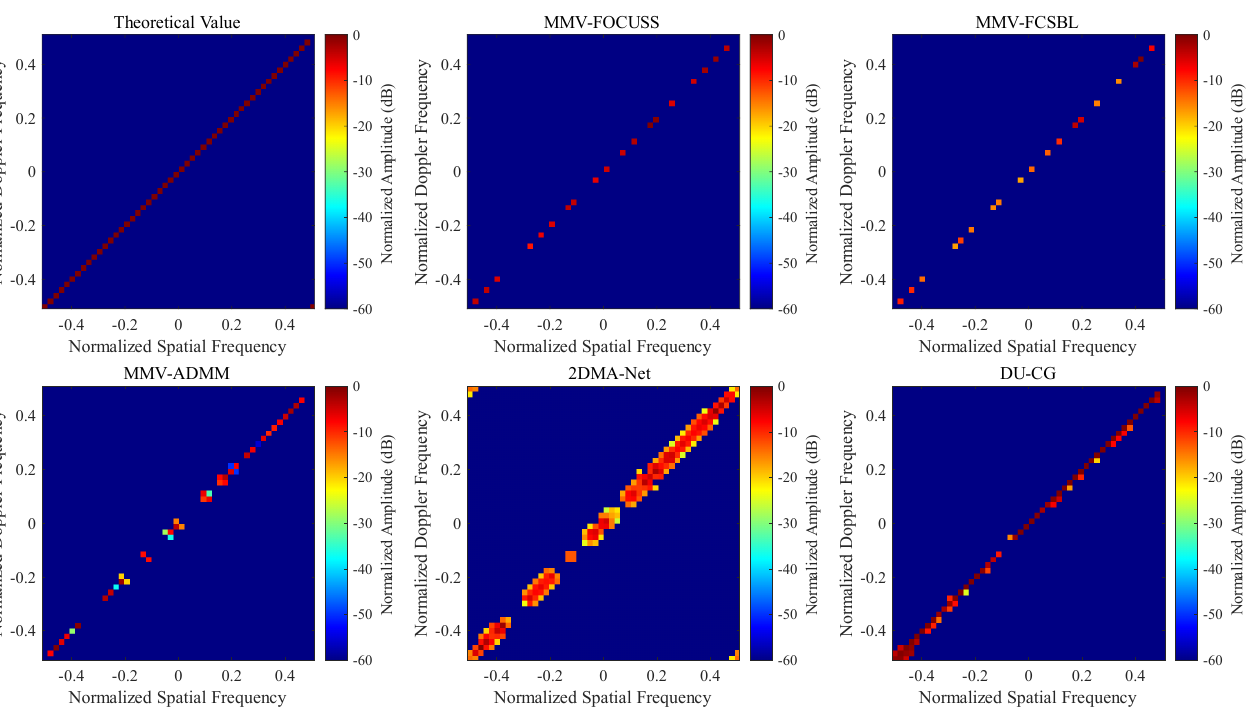
Figure 8. Clutter spectrum estimation results obtained using different methods in the ideal case.